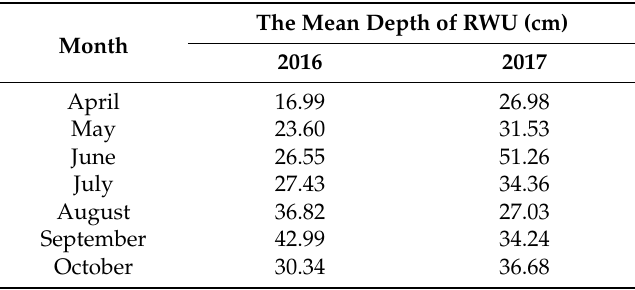
The mean depth of root water uptake (RWU) in surface-irrigated apple using the Romero-Saltos model. The Mean Depth of RWU Month